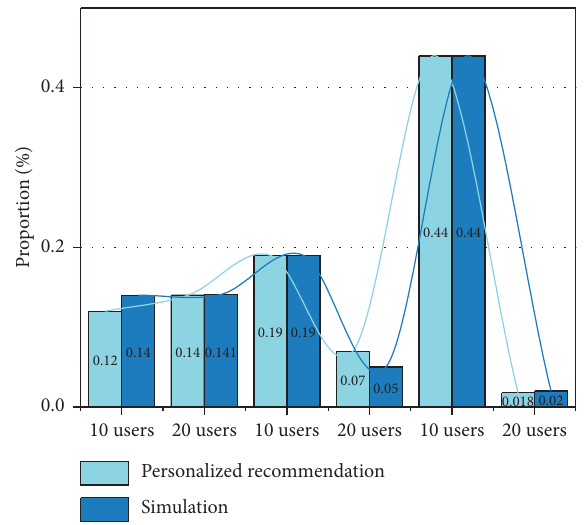
Figure 7: Comparison of isomorphism in clusters of clusters.